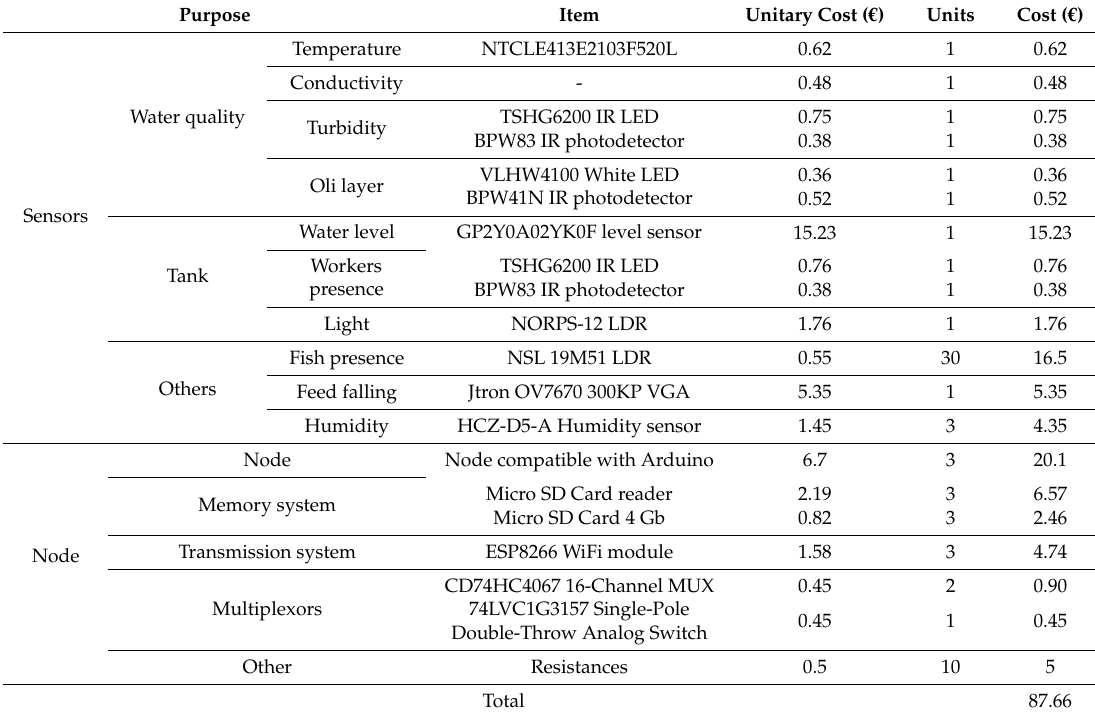
Table 2. Cost of the developed system for each